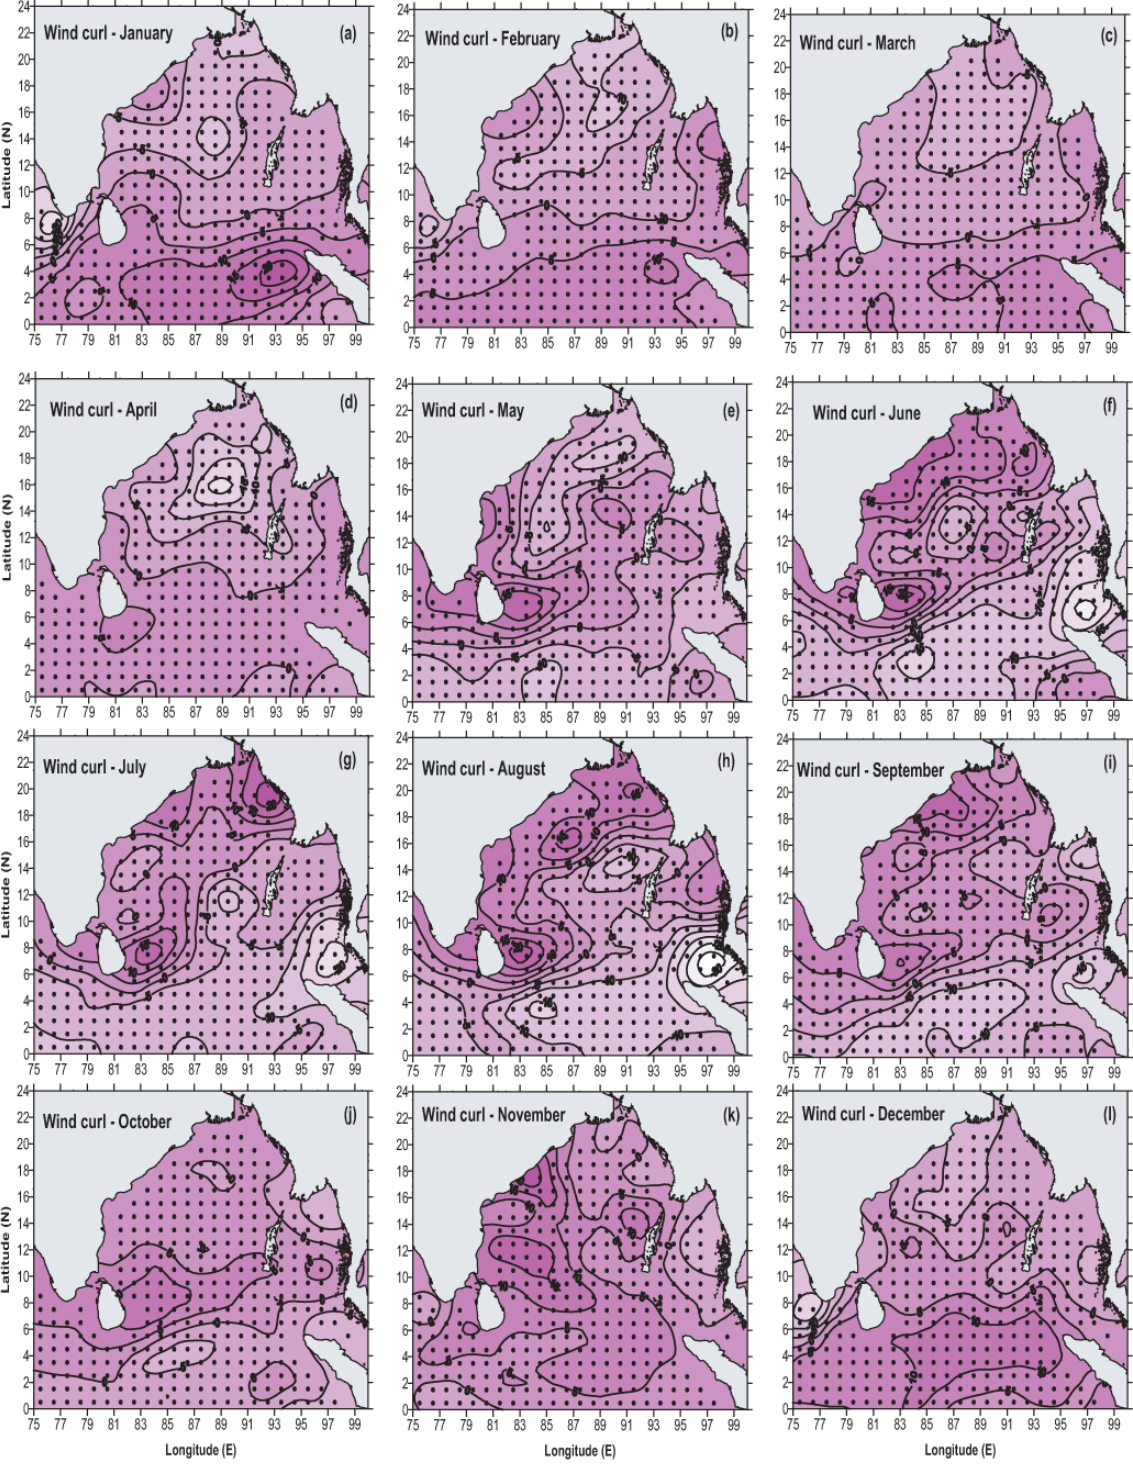
Figure A7. Monthly mean climatology of wind-stress curl ( × 10 − 8 Pam − 1 ) from January to